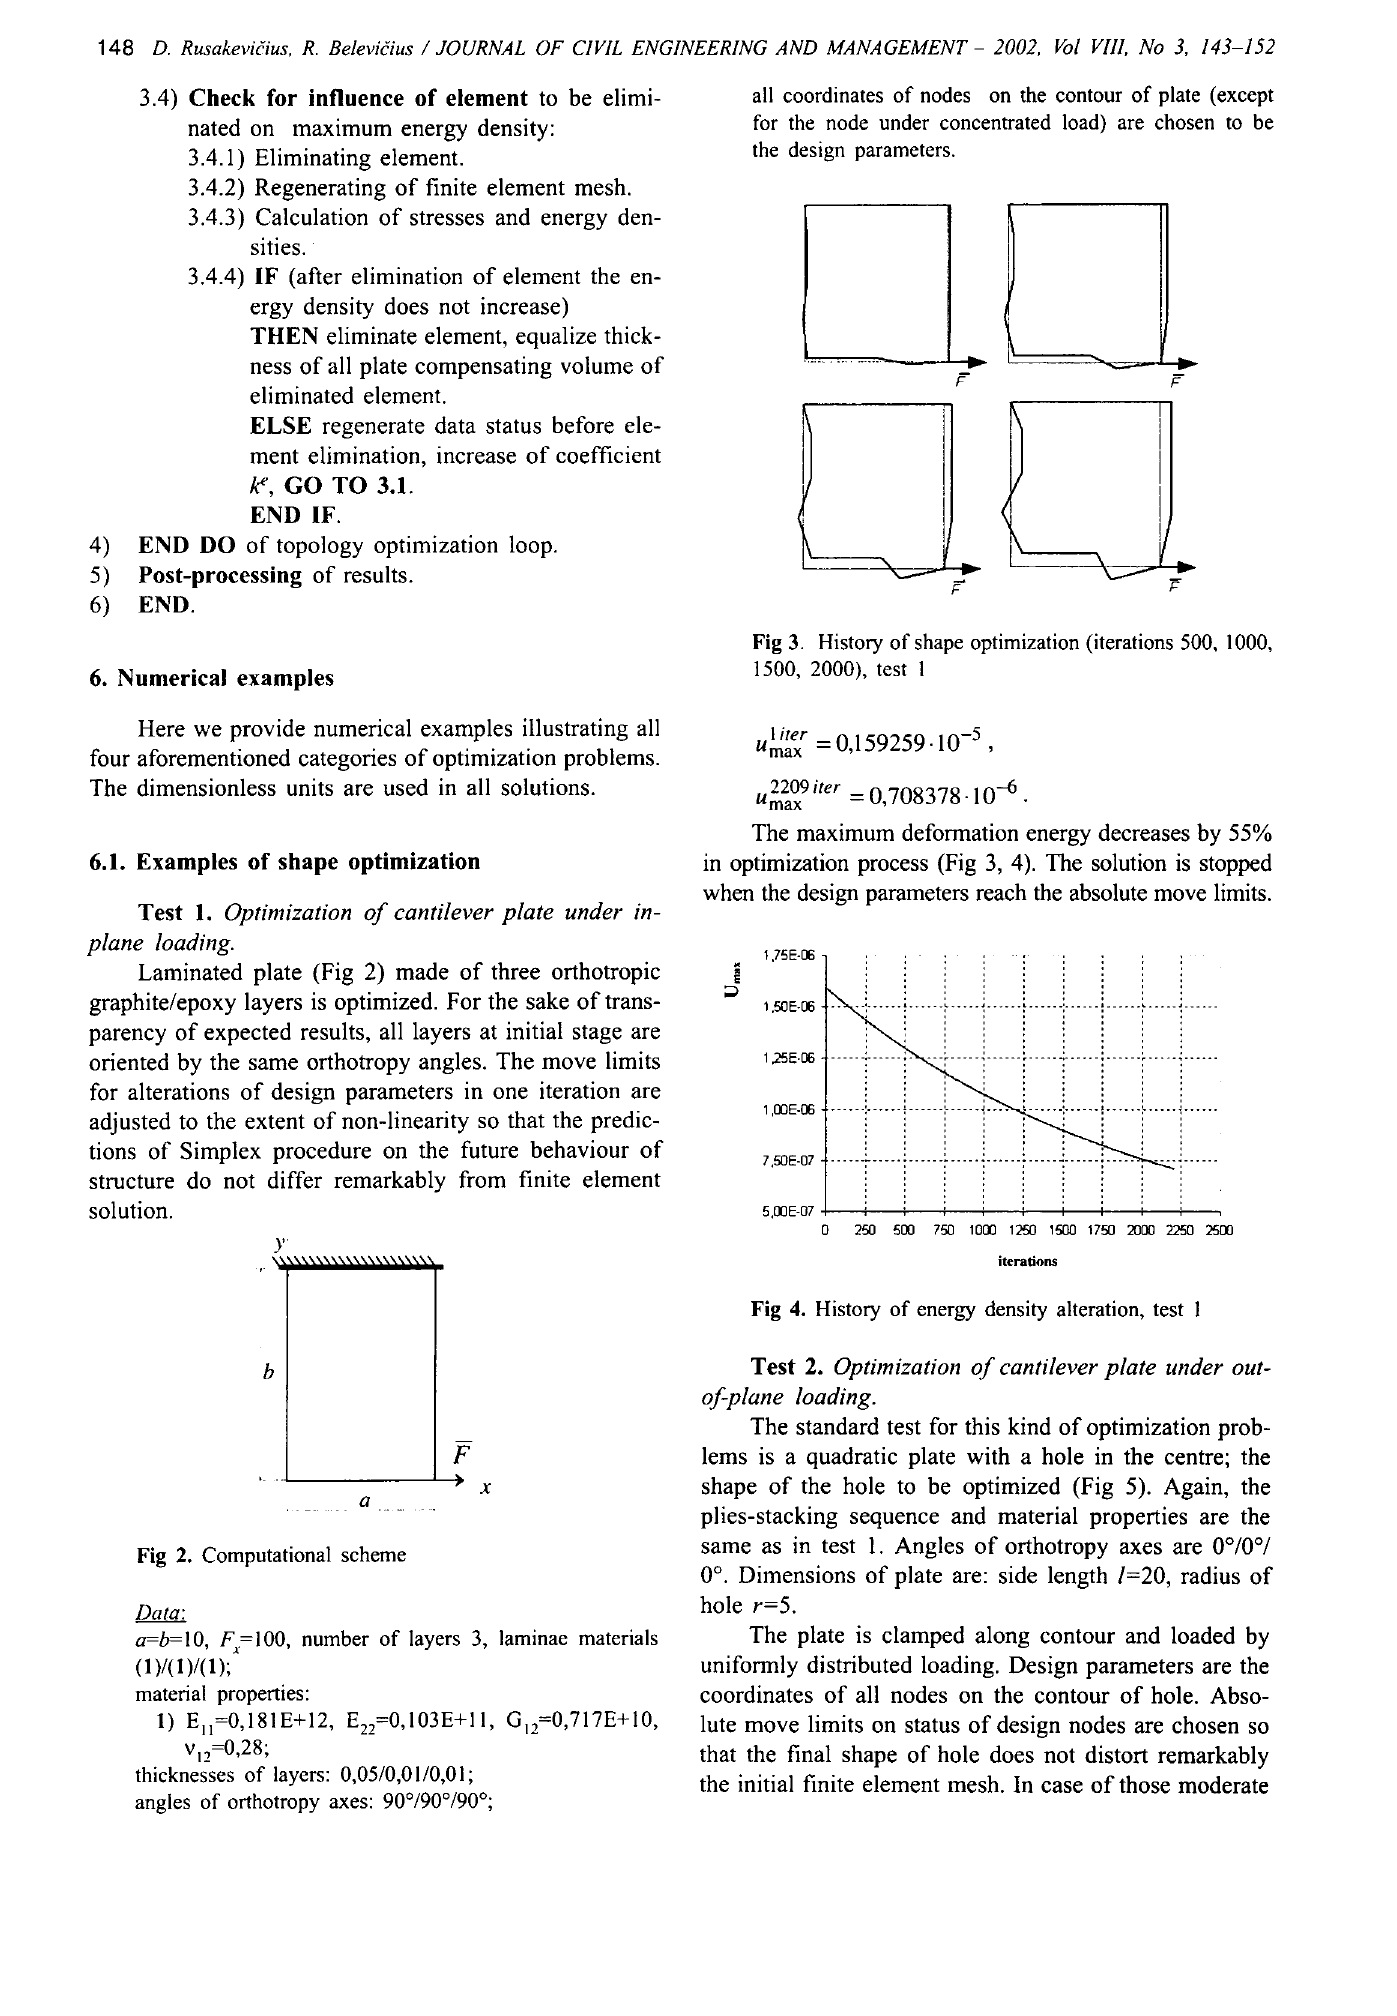
Fig 4. History of energy density alteration, test I Test 2. Optimization of cantilever plate under out of-plane loading. lems is a quadratic plate with a hole in the centre; the shape of the hole to be optimized (Fig 5). Again, the plies-stacking sequence and material properties are the same as in test I. Angles of orthotropy axes are 0°/0°/ 0°. Dimensions of plate are: side length 1=20, radius of hole